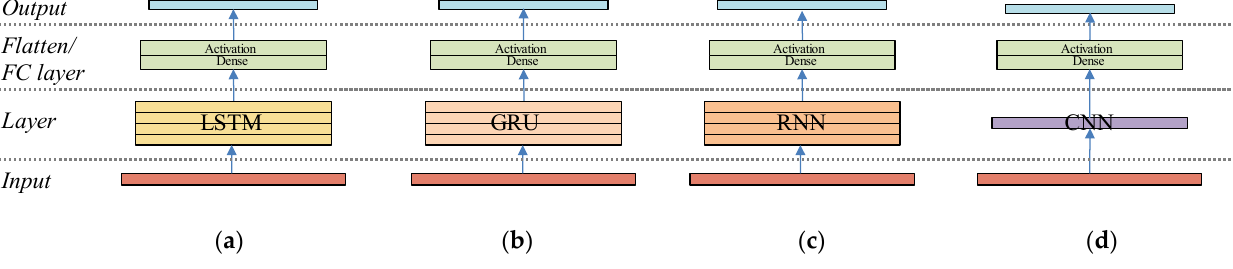
Figure 6. Structure of compared models: ( a ) LSTM, ( b ) GRU, ( c ) RNN, and ( d ) TRT-Net (our approach).